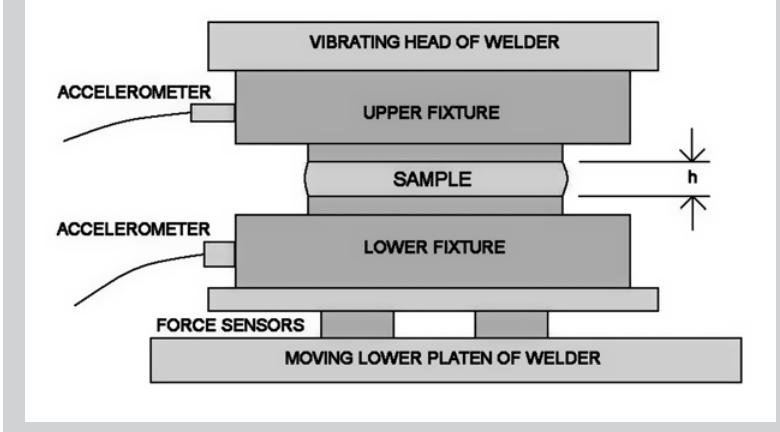
Figure 1: Schematic of the high frequency sliding plate rheometer (HF-SPR)